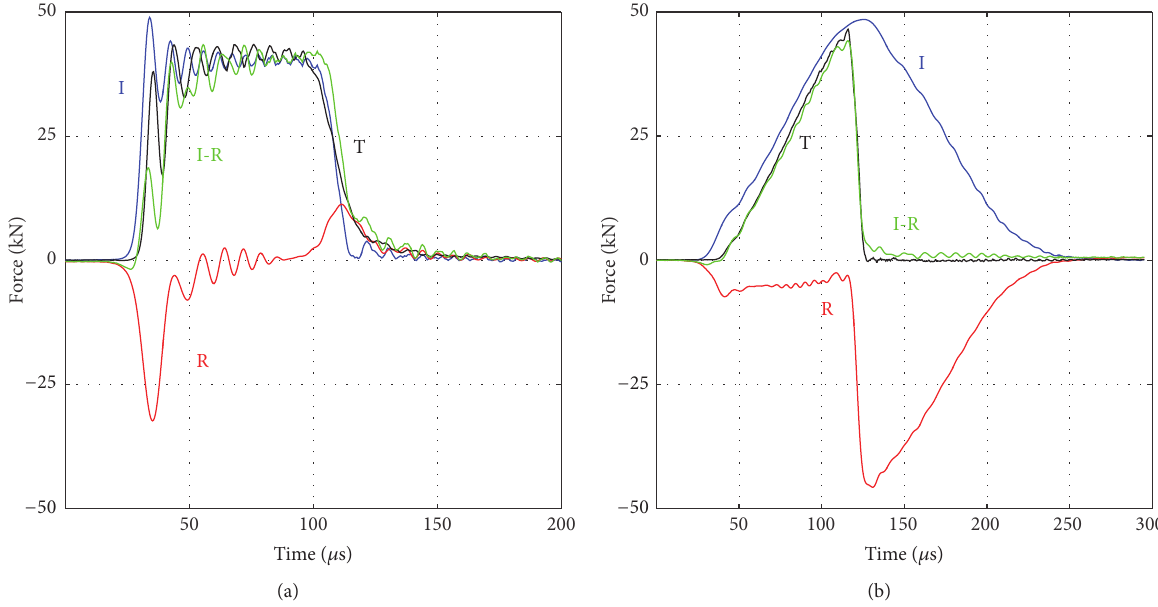
Figure 4: Check of the equilibrium condition on the specimen: waves diagram without (a) and with (b) the pulse shaper.